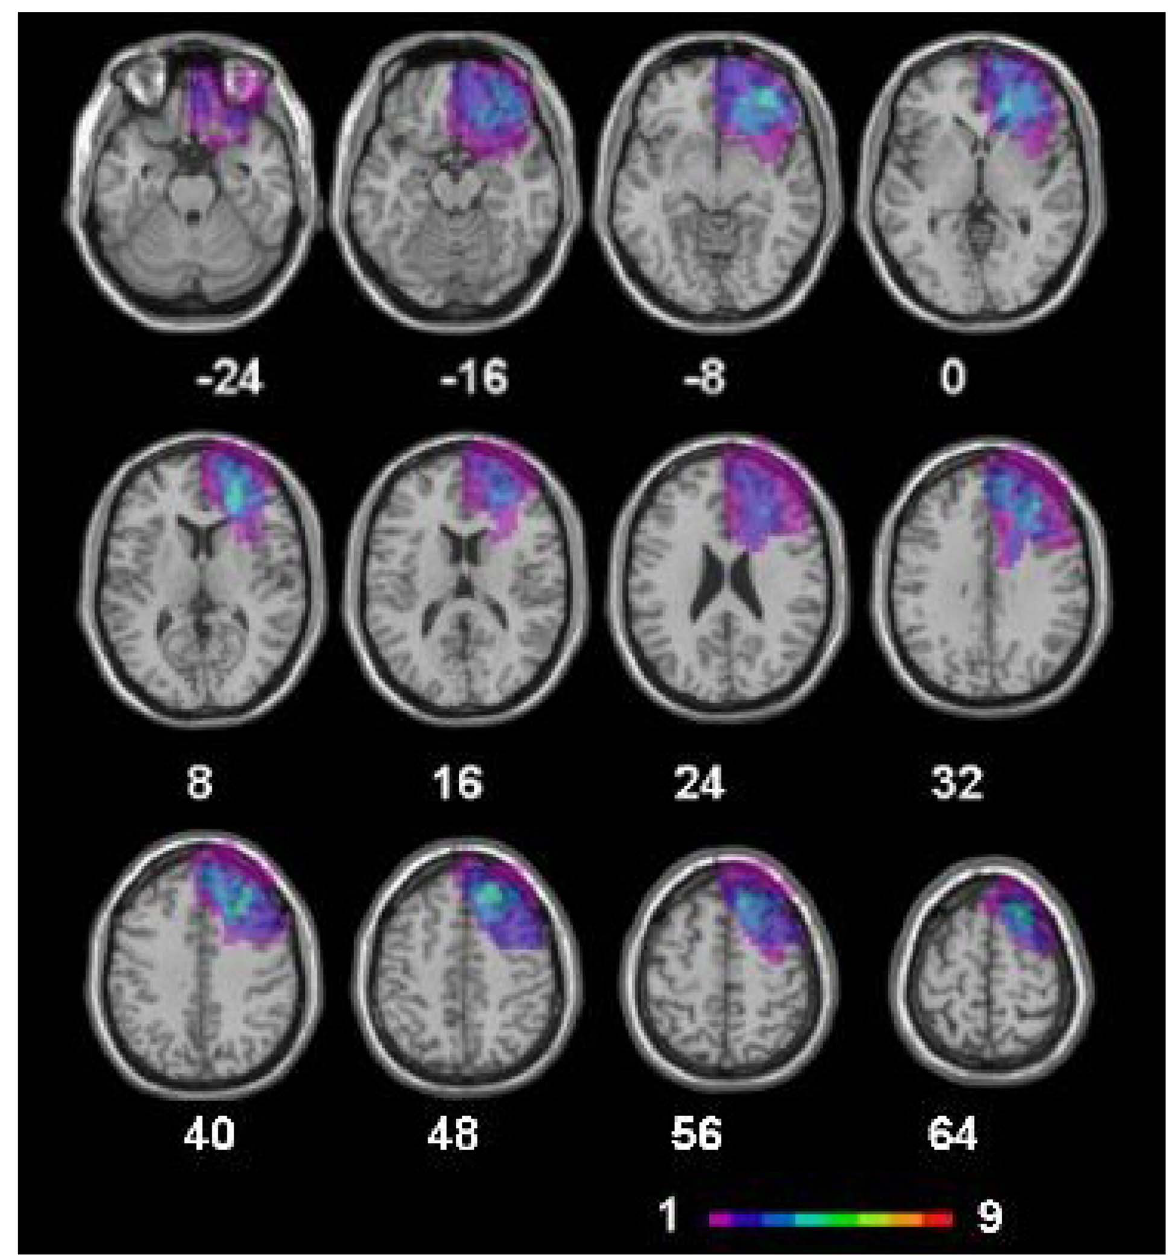
Figure 1. Overlap lesion maps for patients with LFL lesions. Lesions are projected on the same axial slices on a standard brain template. The color bar indicates the number of overlapping lesions. Left hemisphere is on the right side of the figure. 4.1 (FMRIB Analysis Group, www.fmrib.ox.ac.uk/fsl). A lesion